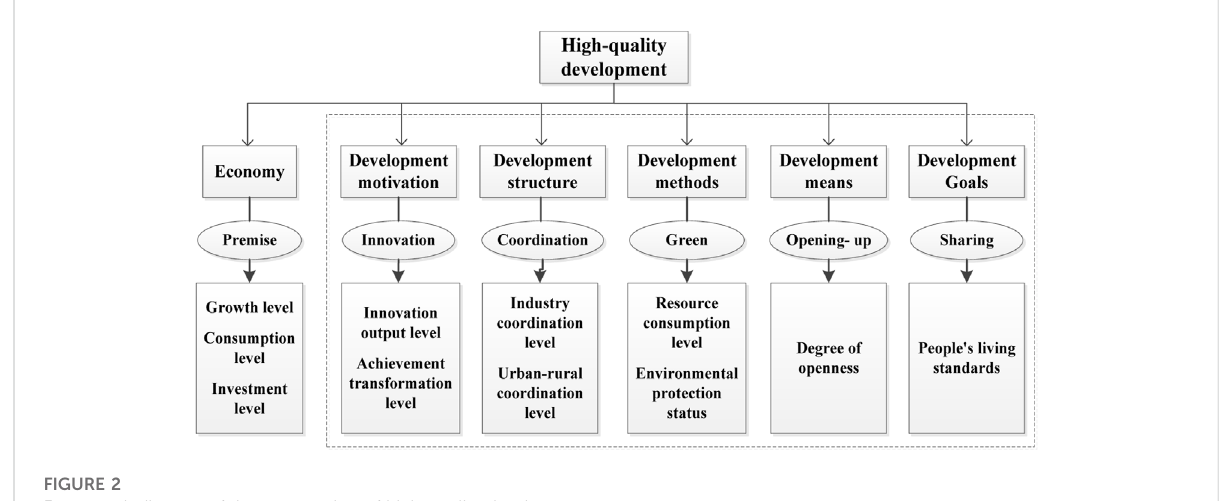
FIGURE 2 Framework diagram of the connotation of high-quality development.